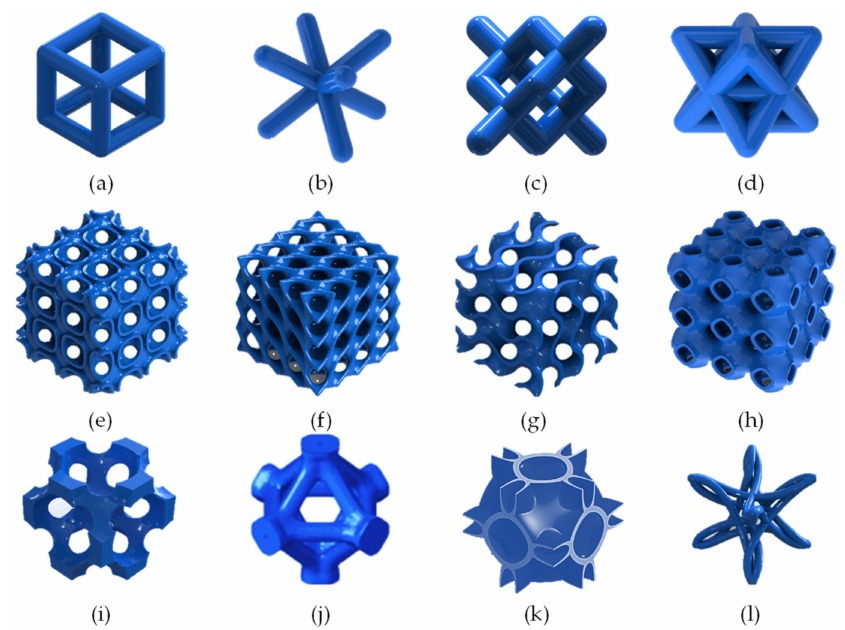
Figure 1. Different types and shapes of unit cells: ( a ) simple cube, ( b ) back-centered cubic BCC, ( c ) diamond, ( d ) octet-truss, ( e ) IWP Schoen, ( f ) Schwartz diamond, ( g ) gyroid, ( h ) Schwartz primitive, ( i , j ) topology-optimized face-centered cubic cells, ( k ) hybrid (Neovius + Schwartz P), and ( l ) custom artistically designed unit